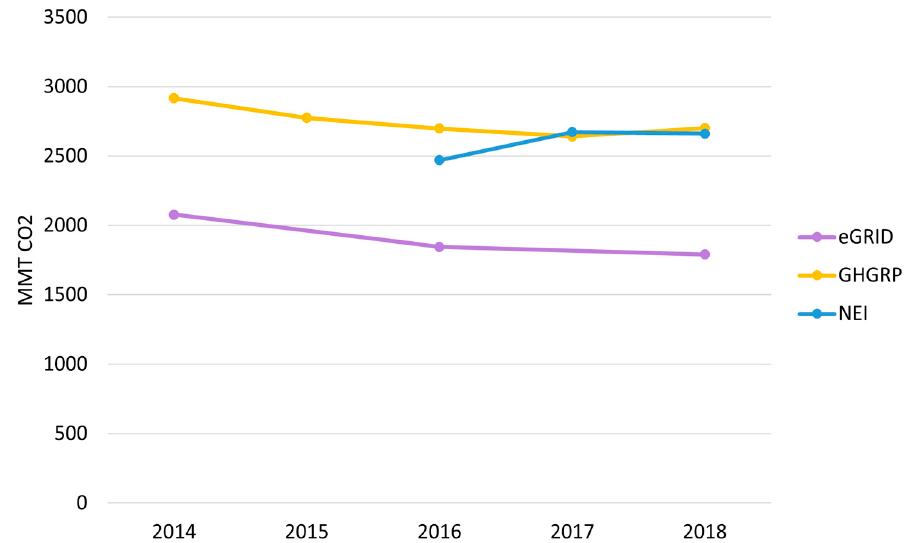
Figure 2. Tracking national emissions by inventory over time.